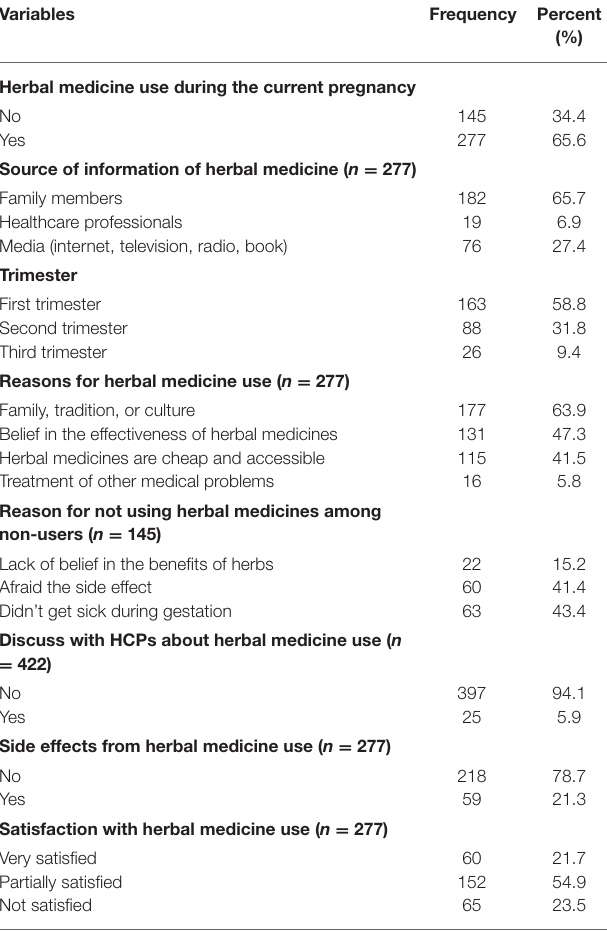
TABLE 2 | Study participant’s characteristics toward herbal medicine utilization at public health institutions in Debre Berhan town, Ethiopia, 2021 ( n = 422).